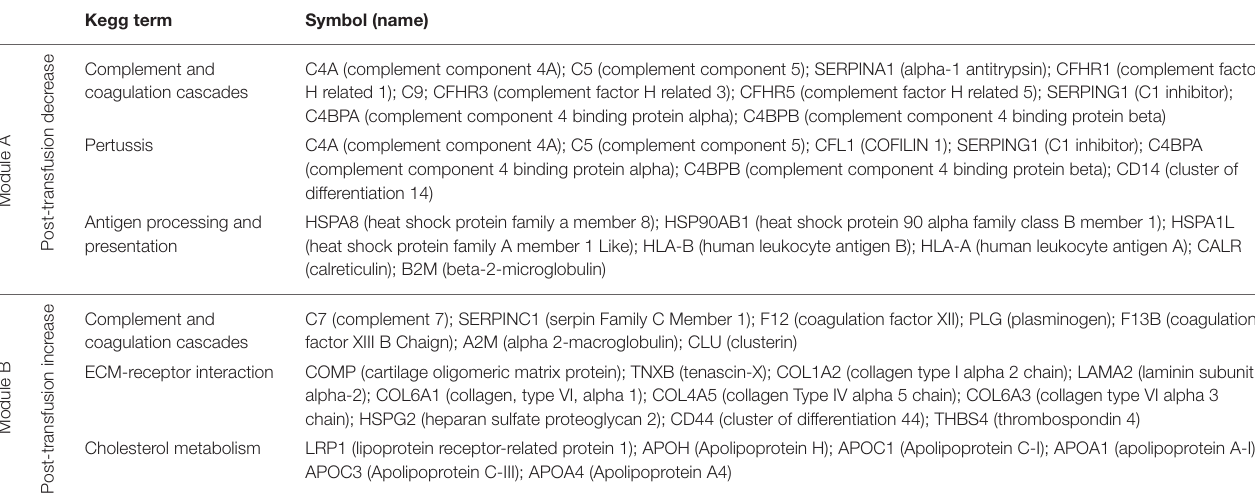
TABLE 1 | Proteins in the top three KEGG pathways that decrease (module A) or increase (module B) post-transfusion. Kegg